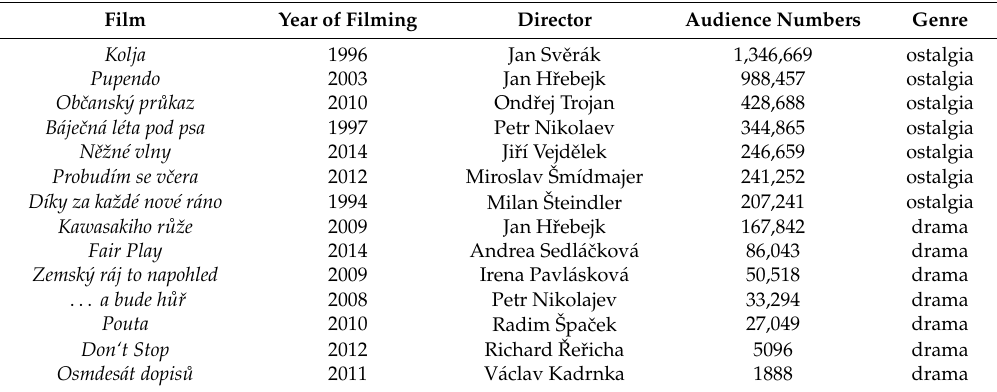
Table 1. Films about normalisation: Audience in cinemas (official data from Union